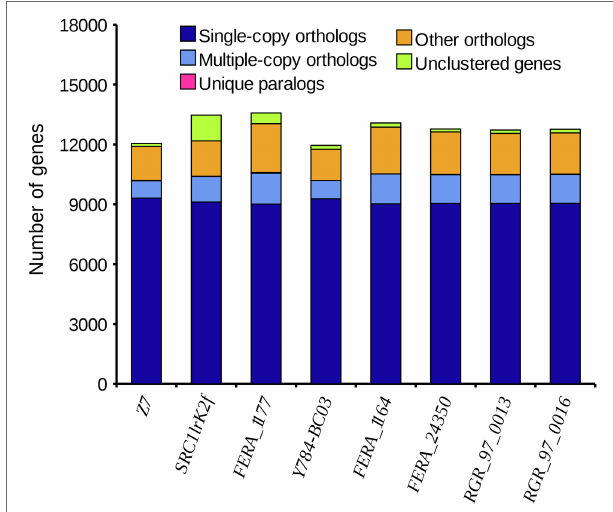
FIGURE 5 | The distribution of different categories of genes in different species of Alternaria . The horizontal and vertical axis represent the species and the number of genes, respectively. Single-copy orthologs represent a single-copy genes that are present in all species. Multiple-copy orthologs are multi-copy genes that are present in all species. Unique paralogs are genes that are only present in the specified species. Other orthologs refer to the number of other gene